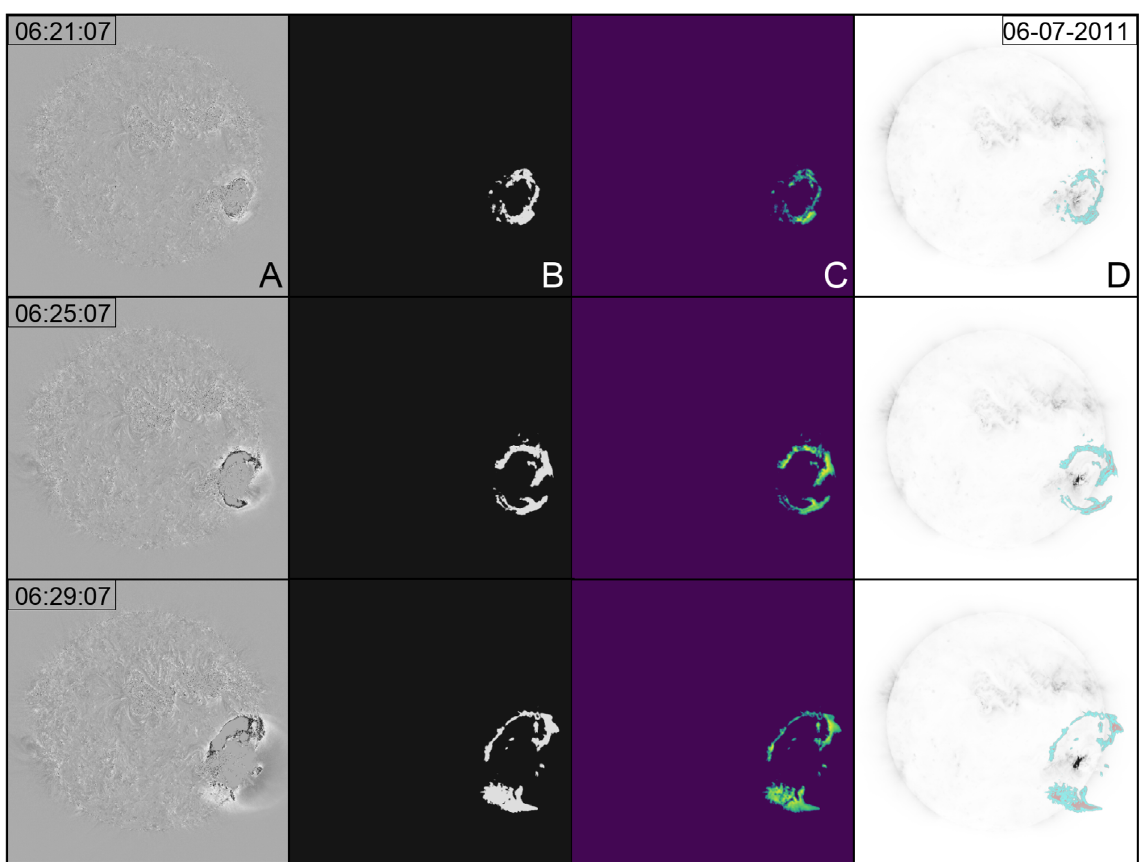
Fig. 3. Demonstration of the Wavetrack application stages four times during the event of June 07, 2011. From left to right, the columns show: A) base difference images, B) recomposed object masks, C) object masks applied to the original data, and D) the applied masks overlaid on base difference images.